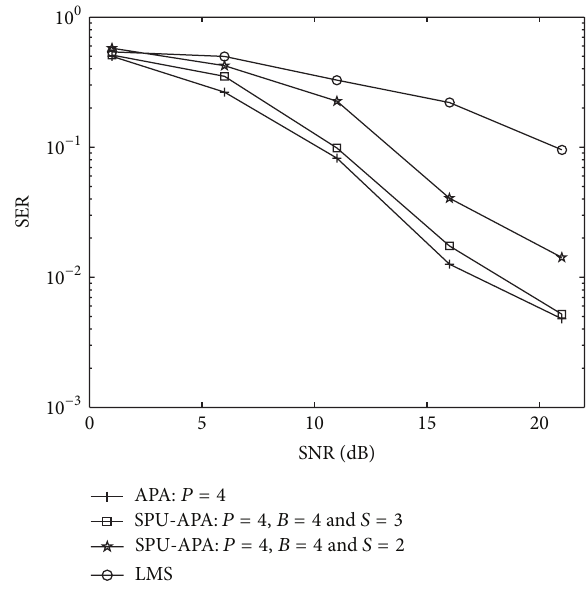
Figure 3: Learning curves for the LMS, APA, and SR-APA with 𝜇 = 10 −9 for LMS and 𝜇 = 0.1 and 𝑃 = 4 for APA and SR-APA.